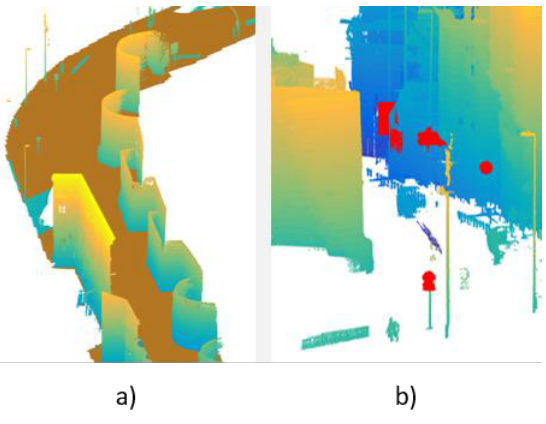
Figure 2. (a) Ground segmentation. The points in the ground (painted in brown) are filtered from the point cloud. (b) Intensity filter. Points of reflective objects (painted in red) are